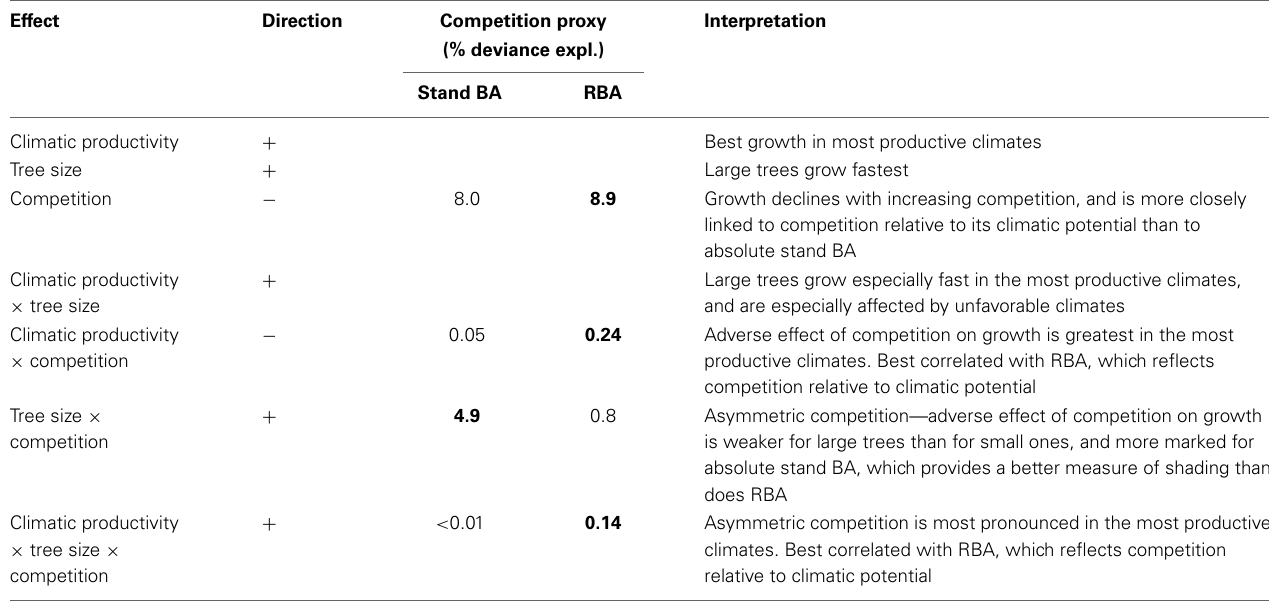
Table 4 | Summary of effects on growth of climatic productivity, tree size, and our proxies for competition (stand BA and RBA), and their interactions, from linear mixed effects modeling.